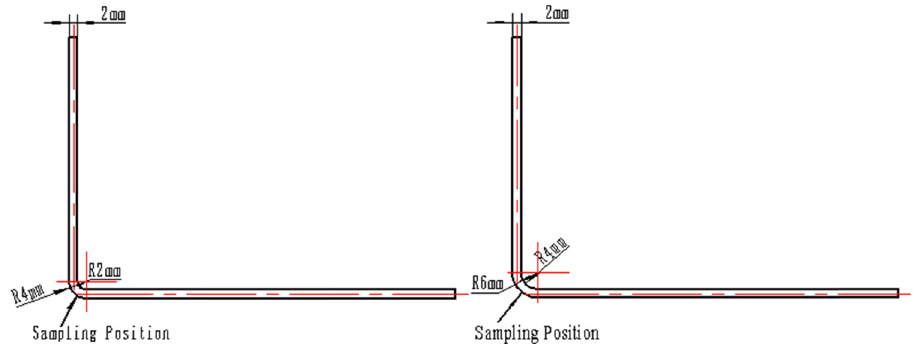
Figure 4: Pure bending schematic and sampling position of hot stamping coating.